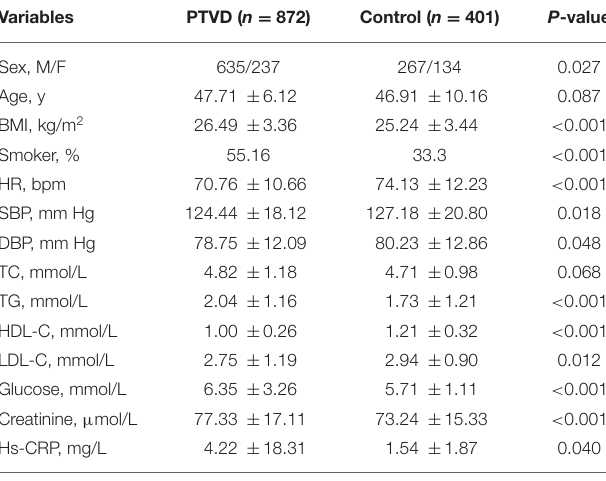
TABLE 1 | Comparison of clinical characteristics between PTVD and